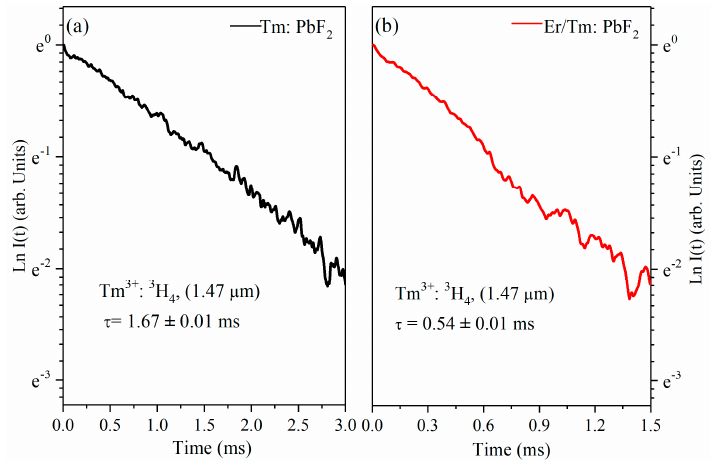
Figure 4. ( a ) Fluorescence decay curves of the Tm 3+ : 3 H 4 energy level of Tm: PbF 2 crystal; ( b ) fluores- cence decay curves of the Tm 3+ : 3 H 4 energy level of Er/ Tm: PbF 2 crystal ( λ ex = 800 nm, λ em = 1470 nm).